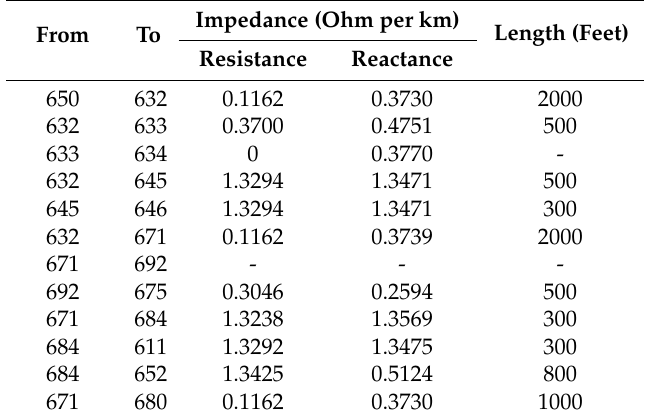
Table 1. Parameters of Transmission Lines.